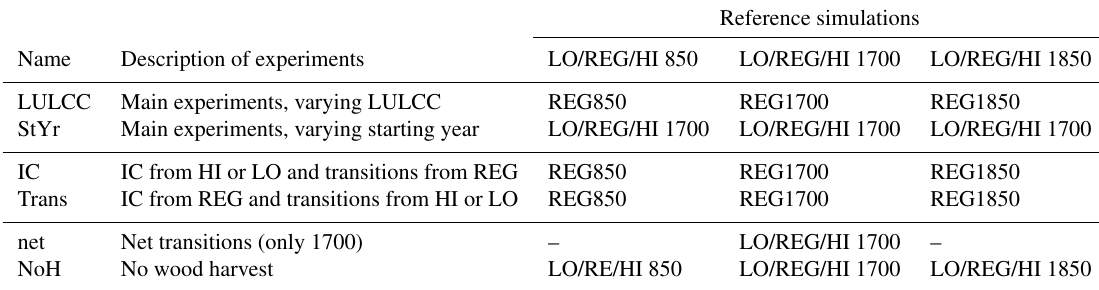
Table 2. Overview of main experiments (first two rows; see also Table 1) and additional sensitivity experiments (third to fifth rows). The first column gives the abbreviation of the experiment type described in the second column, and the last three columns provide reference sim- ulations for the uncertainty analysis (more information in Fig. 3). If not specified otherwise, simulations are conducted with all three starting years (850, 1700 and 1850) and simulated for HI, REG and LO. The two setups with changes to initial conditions (IC) and transitions (Trans) modify the LUH2 dataset and are artificial. To find a reference simulation, the row and column of the last table section can be combined to give one experiment setup (note that LULCC and StYr do not modify the setup, but IC, Trans, net and NoH do). If several reference experiments are given, the ordering is the same as in the column header.